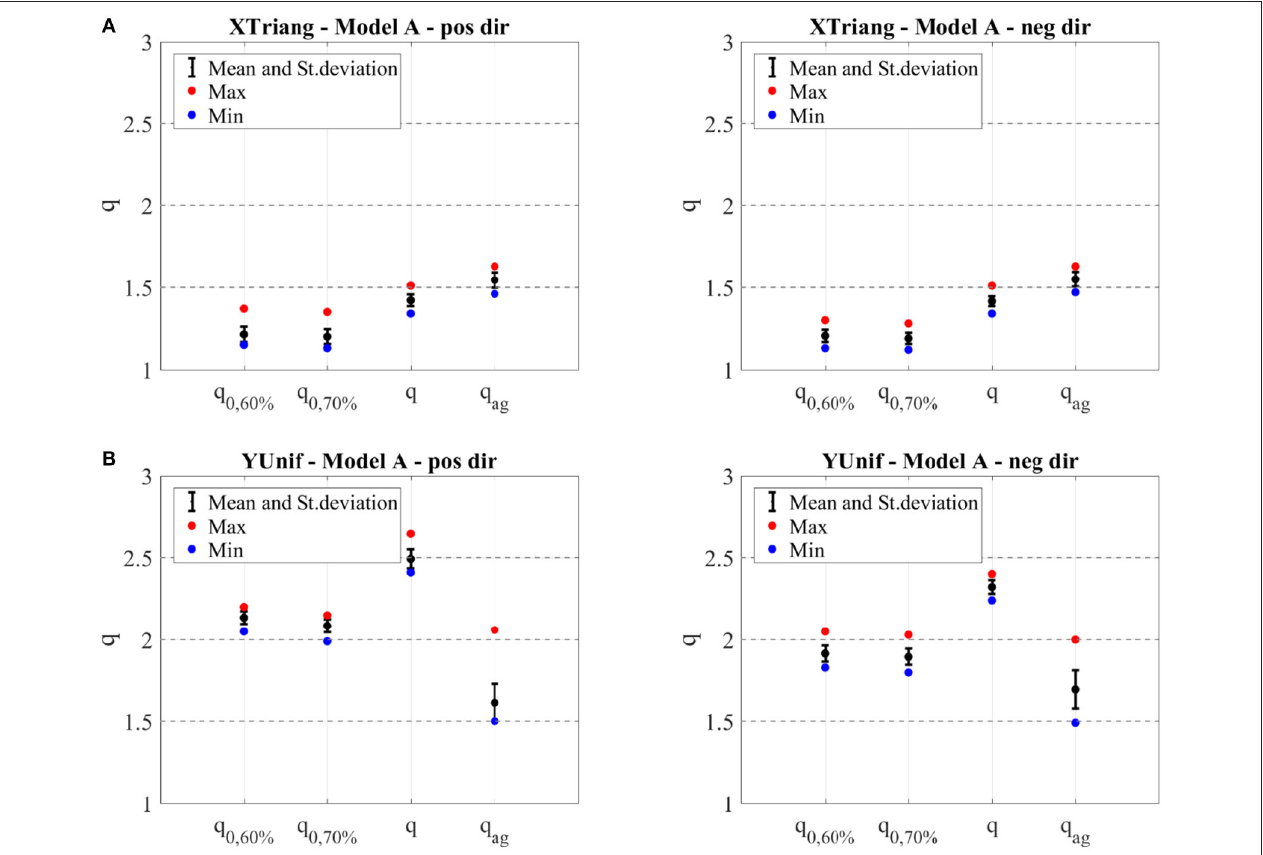
FIGURE 12 | Mean, maximum and minimum values and standard deviation of the behavior factor for X (A) and Y direction (B) for Model A. Doted lines represent the values proposed by NTC Italian Code for Structural Design